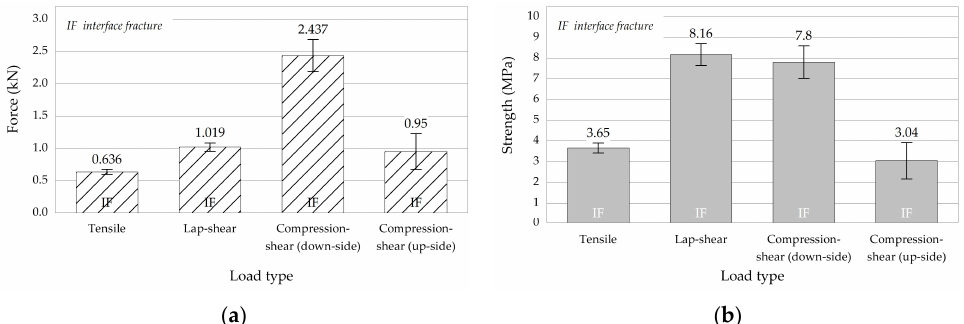
Figure 5. Bar plots of force ( a ) and strength ( b ) each with standard deviation of tensile, lap-shear, and compression-shear multi-material test specimens with fracture pattern.